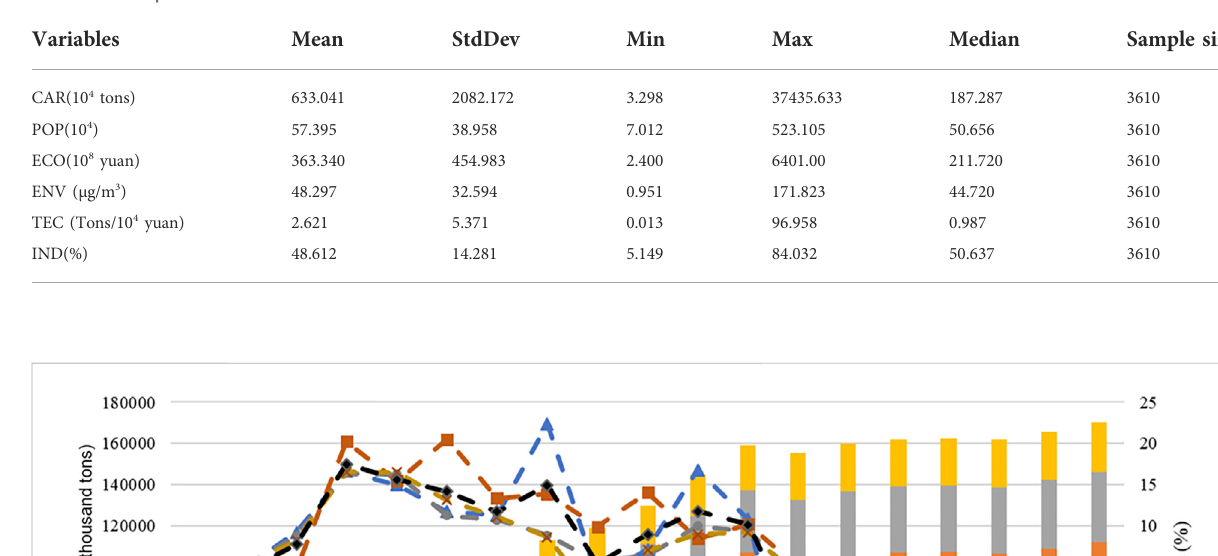
TABLE 1 Descriptive statistics of data.